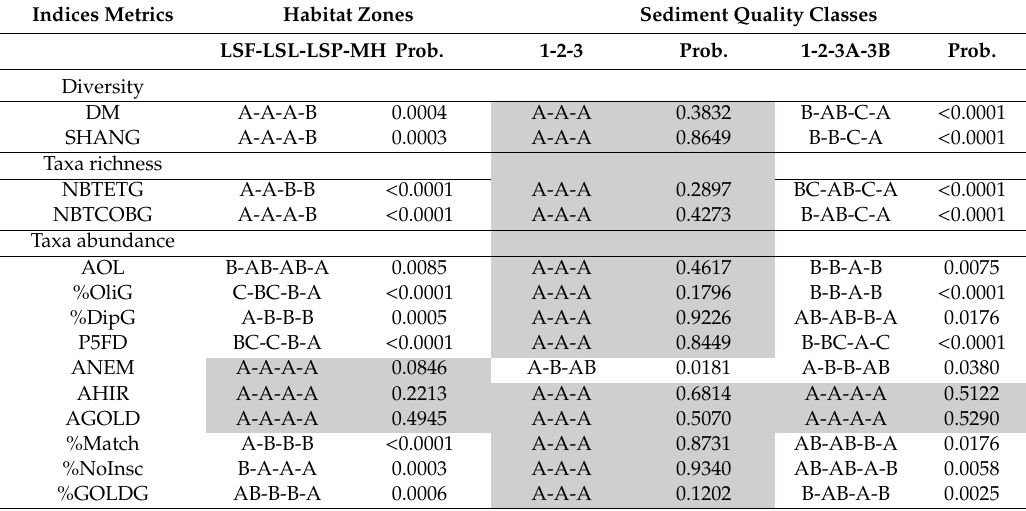
Table 4. Results of ANOVA analyses (classification and probabilities) for the 14 final metrics and indices considering variations among habitat zones (LSF-LSL-LSP-MH) or sediment quality classes based on the remediation framework (1-2-3) and separating sites with contamination and physical stress due to harbour activities (3A) and sites with only historical sediment contamination (3B). Non-significant tests